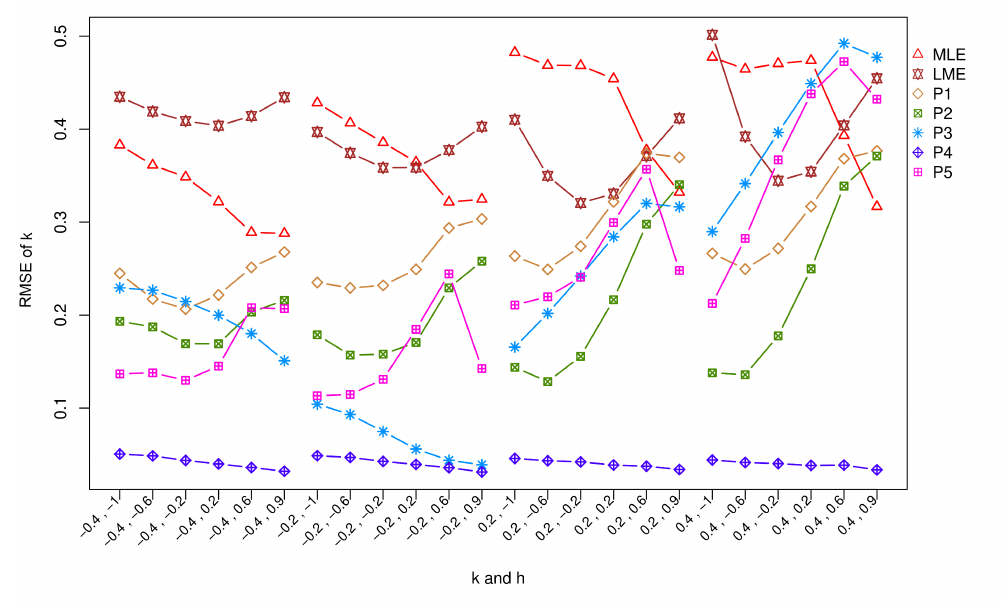
Figure 3. The root mean squared error (RMSE) of the estimates of k under various combinations of k and h for sample size 30. The MLE, LME, and Pi are the maximum likelihood estimator, the method of L-moments estimator, and the Bayesian estimators with five priors Pi (P1 to P5), respectively.